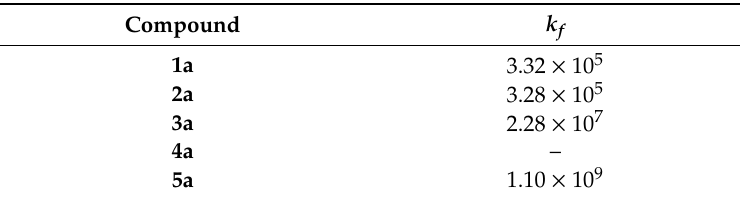
Table 3. The binding constants ( k f ) of Cu 2 + with the derivative 1a – 5a